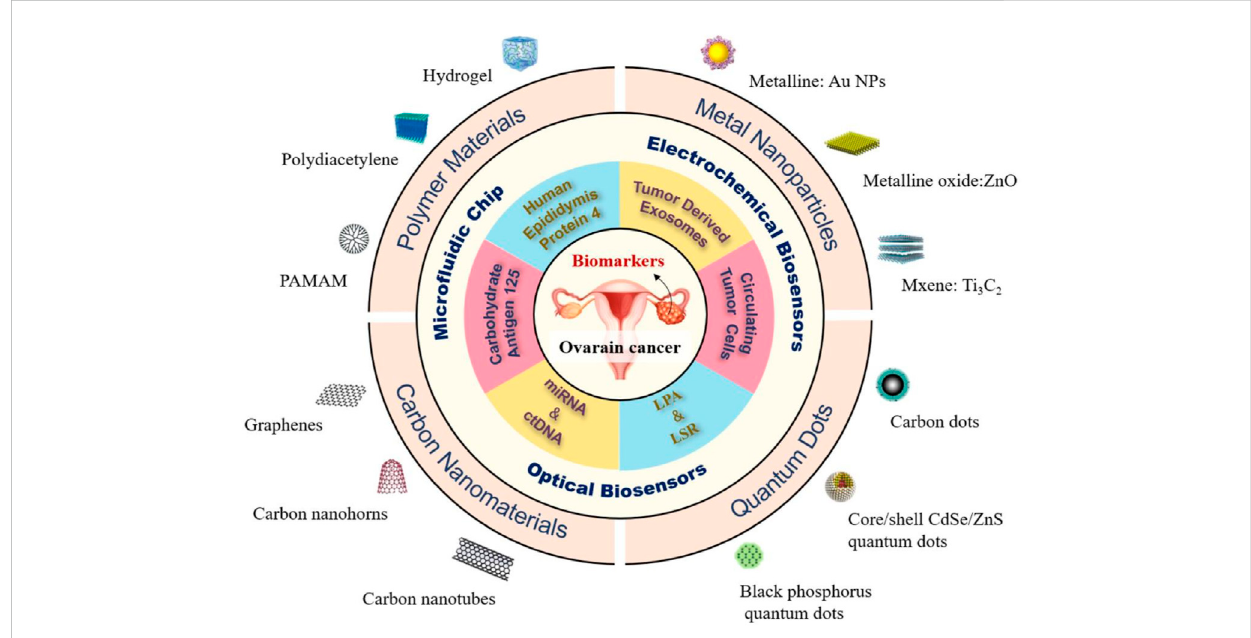
FIGURE 3 The OC biomarkers detection with different strategies including optical biosensors, micro fl uidic chips, and electrochemical biosensors, in combination with nanomaterials, including carbon nanomaterials, quantum dots (QDs), polymer materials, and metal NPs (Yang et al.,